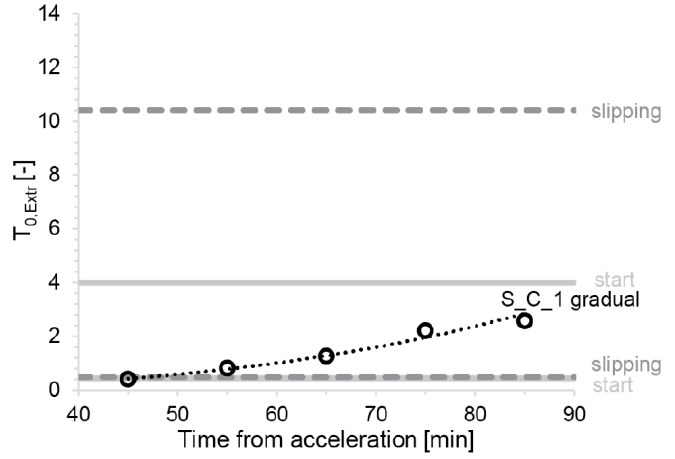
Figure A5. The process window expressed with the dimensionless yield stress for the start of slipping with a typical formwork for thin folded structures when ‘S_A_1 gradual’ material is used for the process.